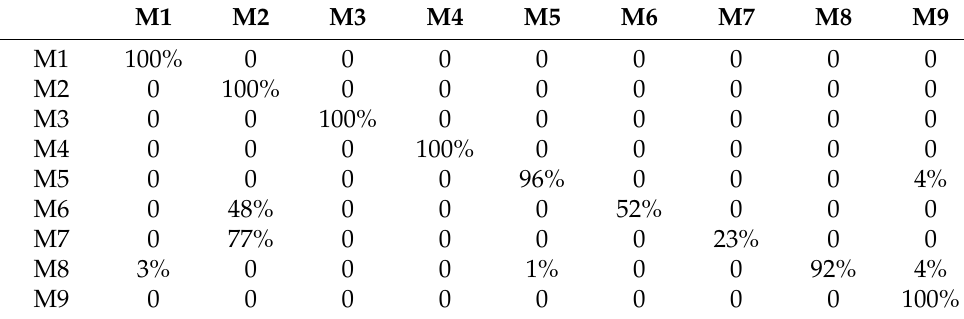
Table 3. Confusion matrix for CA-CFAR.